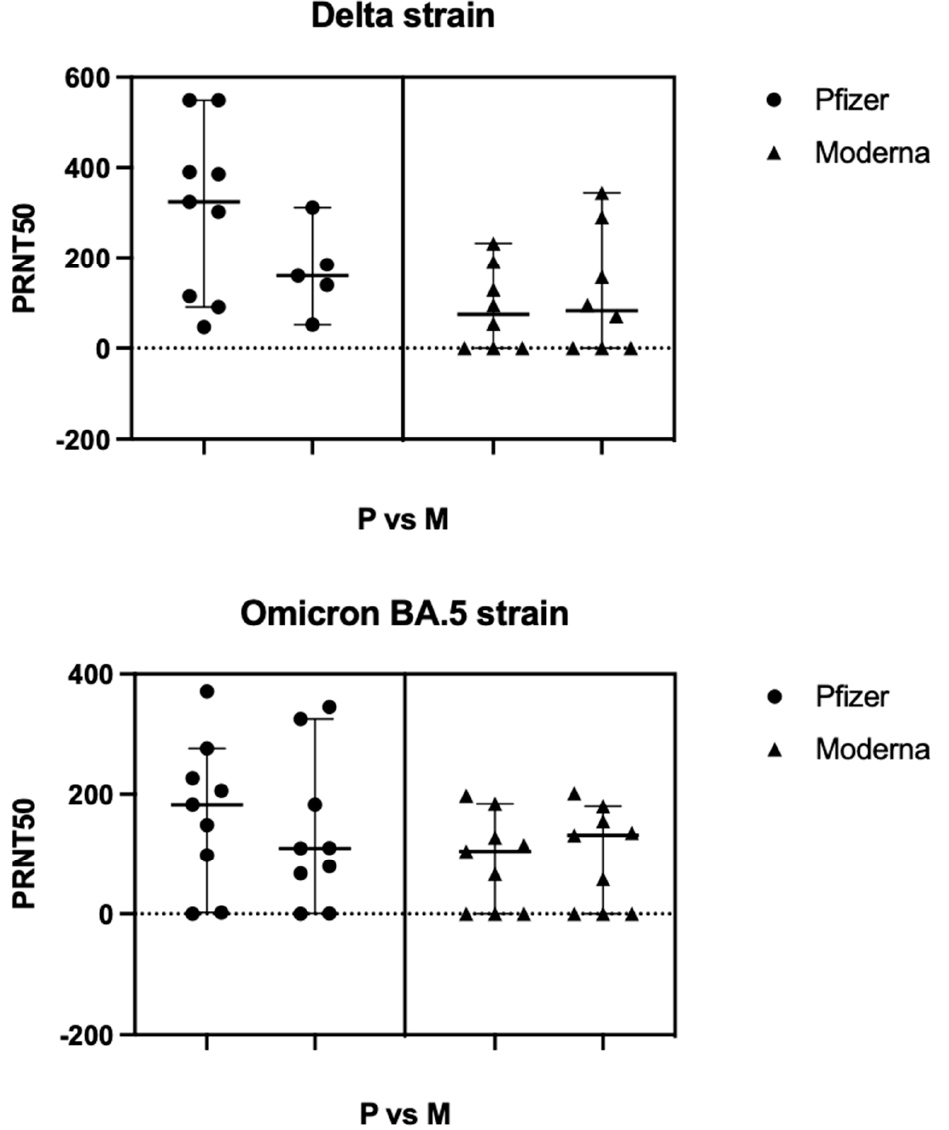
Figure 5. Comparison of PRNT50 titers obtained following vaccination with the primary doses of the Moderna or Pfizer/BioNTech mRNA vaccines. Viral load of 6 × 10 3 PFU/mL (30 plaques/well) were added to Vero-E6 cells. Data represented median ± 95% CI of two biological replicates.